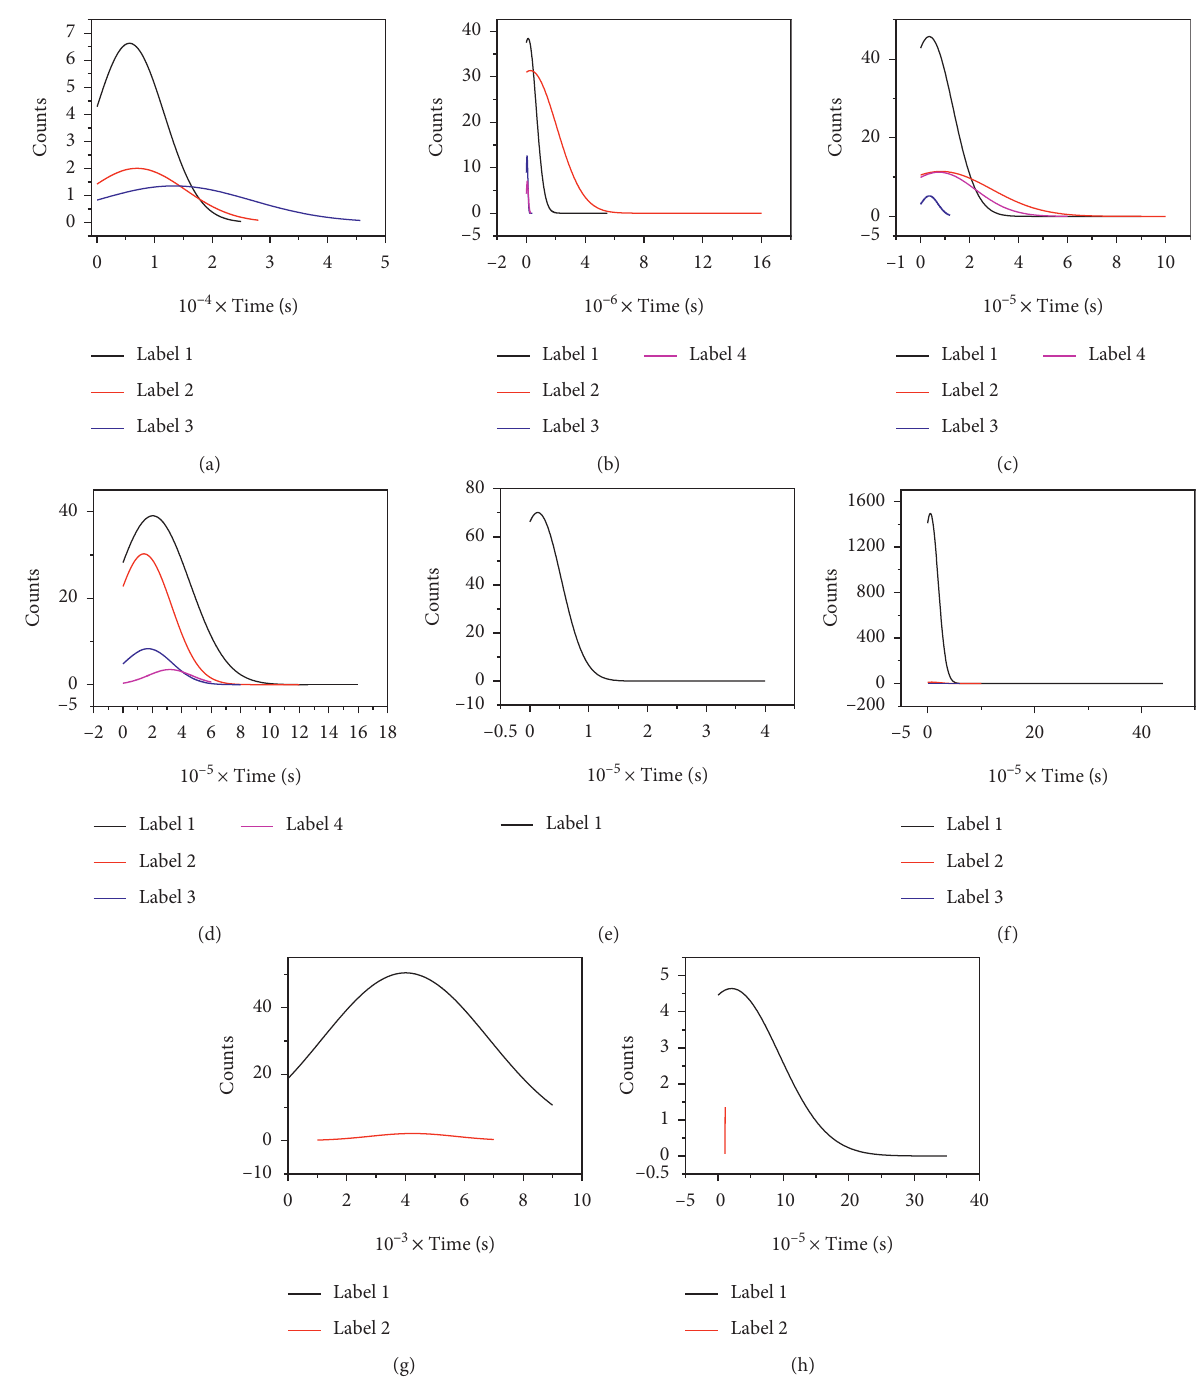
Figure 1: Linear time distribution curve of network